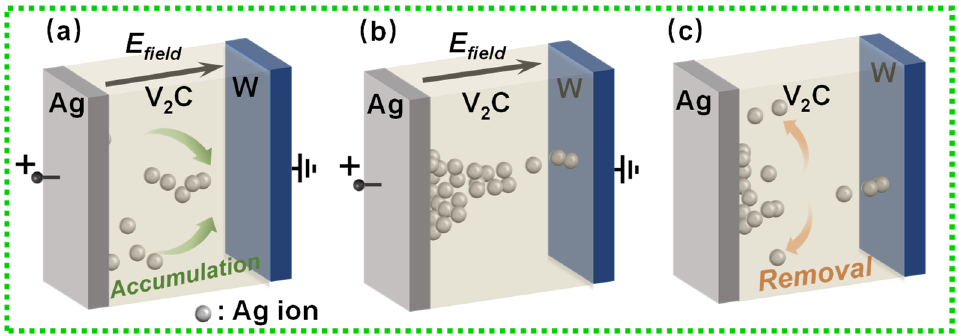
Figure 3. Illustration of dynamic conductive silver (Ag) ions in V 2 C-based memristors. ( a ) Diffu- sive process of Ag ions in TS mechanism. ( b ) ON state constructed by Ag conductive filaments. ( c ) Automatic removal of conductive filaments without